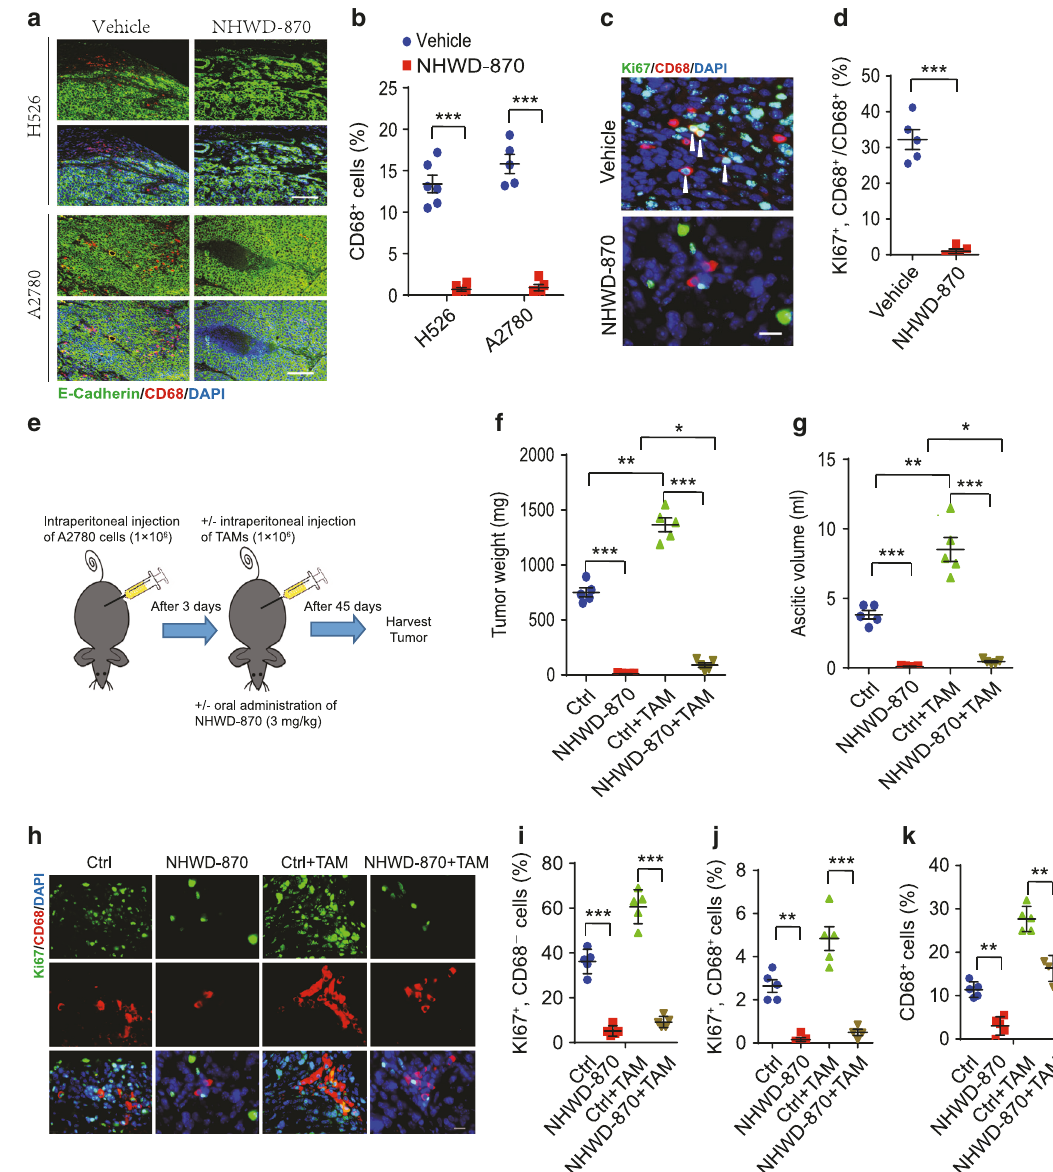
Fig. 4 NHWD-870 reduced the proliferation of TAMs in vivo. a , b NHWD-870 treatment reduced the number of TAMs in subcutaneously implanted H526 and A2780 tumors. Shown are immuno fl uorescent staining of CD68 (macrophage marker, red) and E-Cadherin (cancer cells, green) ( a ) and quanti fi cation of CD68 positive cells ( b ) in vehicle, NHWD-870 treated H526 ( n = 6) and A2780 ( n = 5) tumors from Fig. 3a, b, respectively. Scale bar is 100 μ m. Data are presented as mean ± SEM from different tumors. c , d NHWD-870 treatment reduced the proliferation TAMs in subcutaneously implanted A2780 tumors. Shown are representative immuno fl uorescent staining of Ki67 and CD68 ( c ) and quanti fi cation of percentage of Ki67 + cells in CD68 + cells ( d ). Scale bar is 30 μ m. Data are presented as mean ± SEM of fi ve different tumors. e Schematics of the animal experiments using an orthotopic mouse OC model, established by intraperitoneally injecting human A2780 cells into female recipient nude mice. Mice were then either untreated (Ctrl) or treated with NHWD-870 (PO, QD, 3 mg/kg) for 45 days. Half of the recipient mice received A2780 cells plus TAMs isolated from tumors of OC-bearing donor mice. f , g Tumor weights ( f ) and ascitic fl uid volumes ( g ) at day 45 for mice in ( e ). Data are presented as mean ± SEM from fi ve different mice. h – k NHWD-870 treatment decreased proliferation of the both tumor cells and TAMs. Shown are representative immuno fl uorescent staining of Ki67 and CD68 ( h ) and quanti fi cation of Ki67 + CD68 − ( i ) or Ki67 + CD68 + ( j ), or CD68 + cells ( k ). Scale bar is 50 μ m. Data are presented as mean ± SEM from fi ve different mice. p values were calculated using two-tailed, unpaired t tests in this fi gure. * p < 0.05; ** p < 0.01; *** p < 0.001. Source data are provided as a Source Data fi A2780 cells (Fig. 6b, d), suggesting that these treatments act through the same pathway.